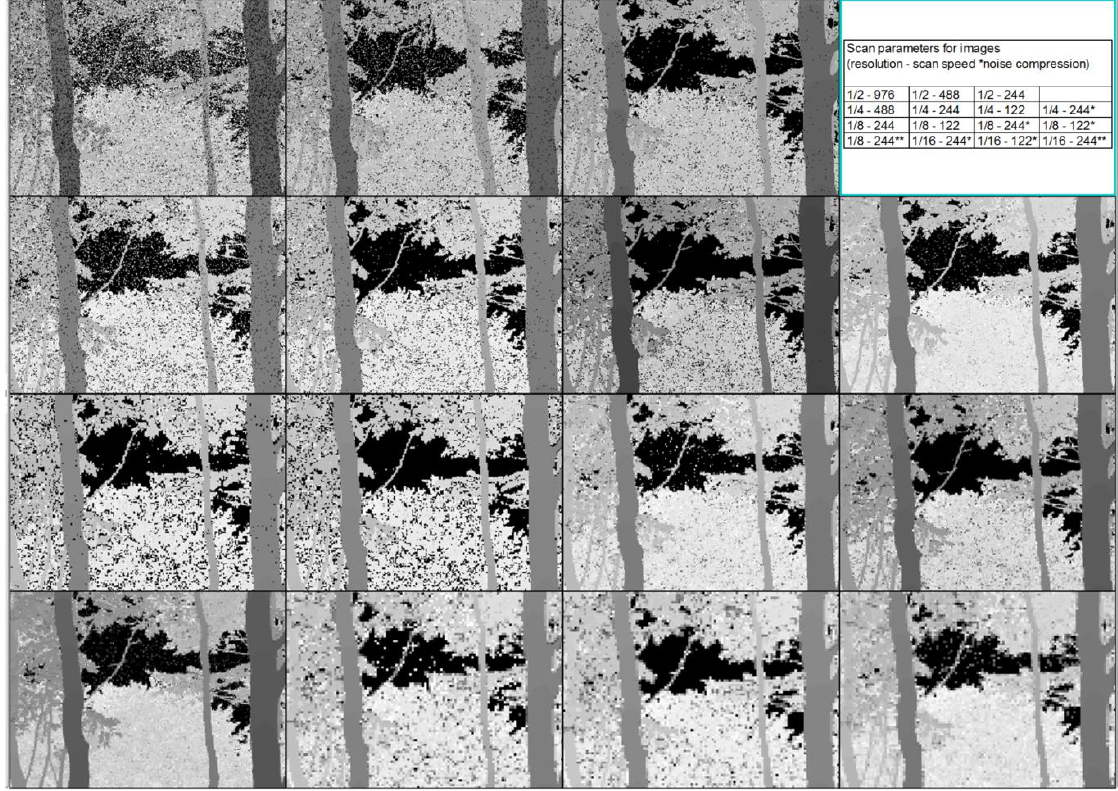
Figure 1. Scan range images based on the different scan parameter sets applied in this study. Legend: Scan resolution is displayed as the fraction of the full resolution (40,000 points per 360°). Scan speed is displayed in kilo-points per second. The single asterisk denotes scans performed with 2× noise compression and the double asterisk denotes scans performed with 4× noise